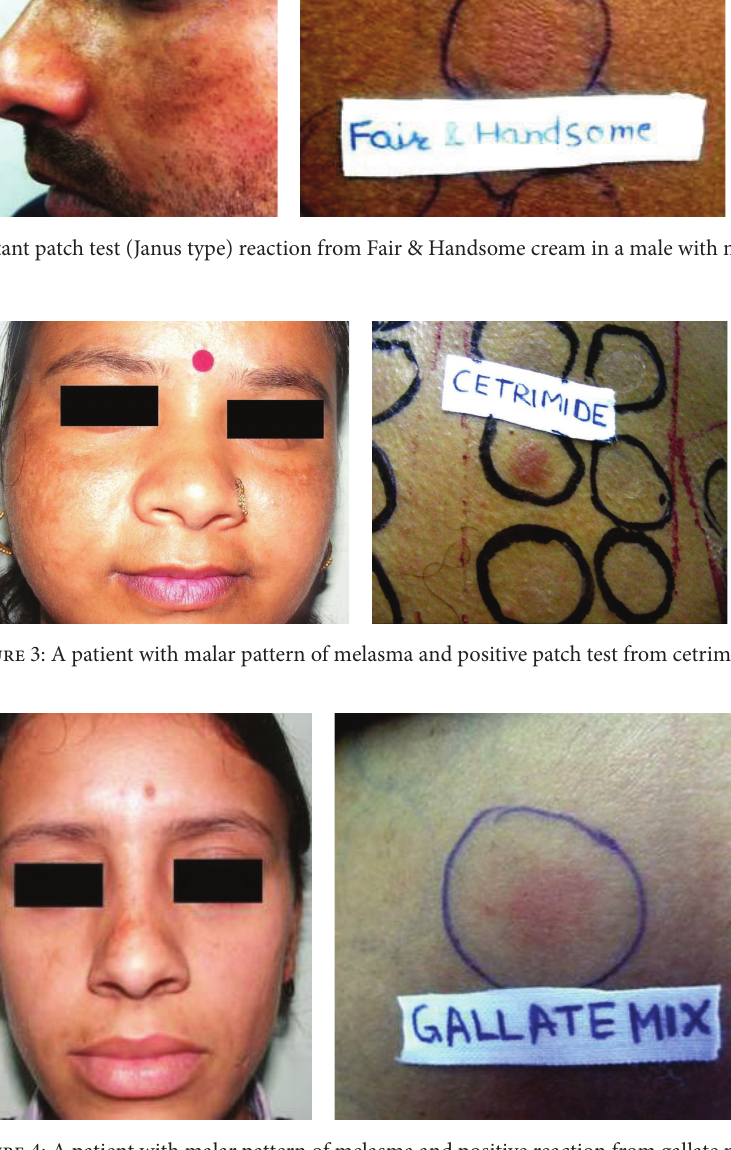
Figure 4: A patient with malar pattern of melasma and positive reaction from gallate